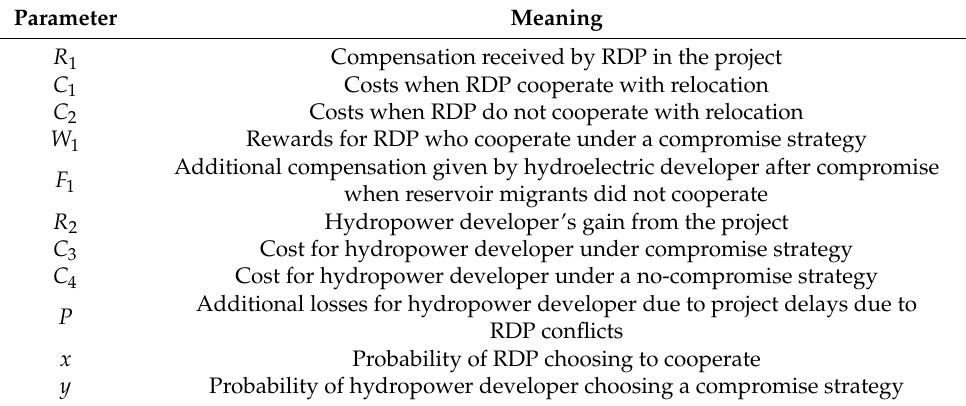
Table 2. Relevant parameters and their meanings in the game model. Parameter